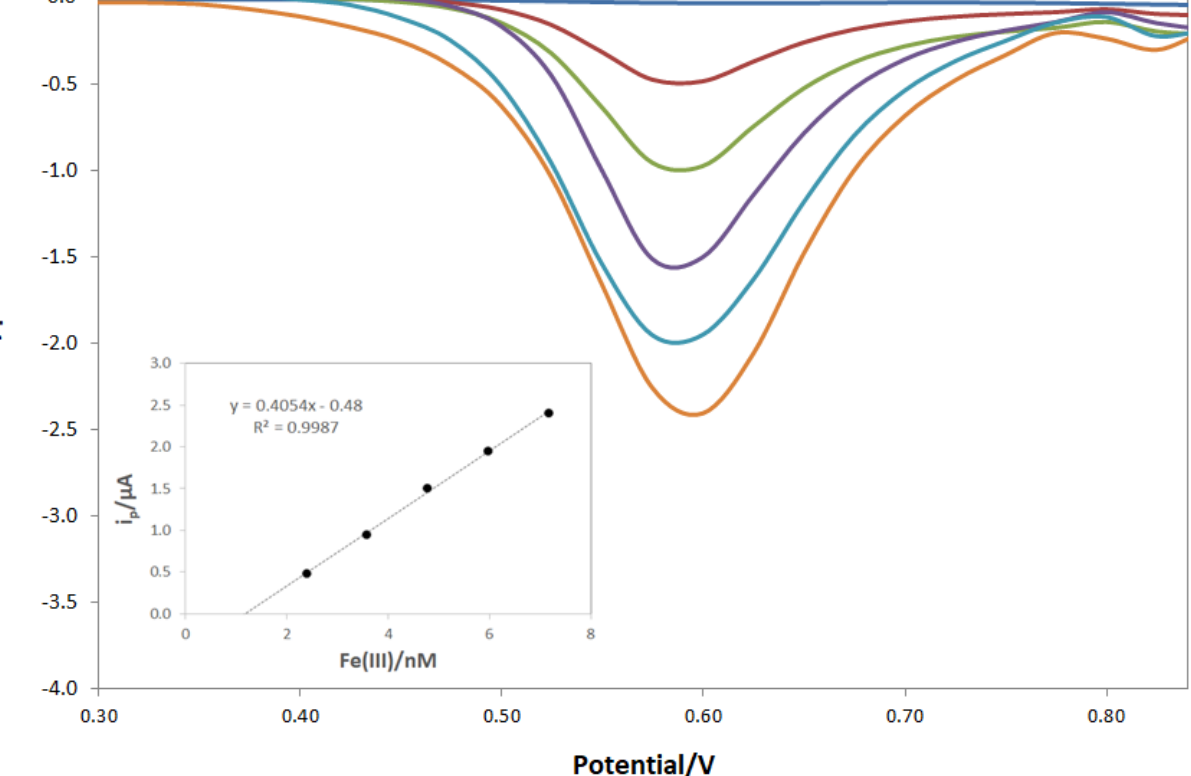
Figure 7. DPV plot obtained on the gold working electrode functionalized with DFO after immer- sion in simulated tap water sample diluted 10-fold with nitric acid solutions at pH 1. Addition of Fe(III) from 0 to 7 nM. The calibration curve is reported as inset. The procedure and conditions are described in the text and caption of Figure 4.